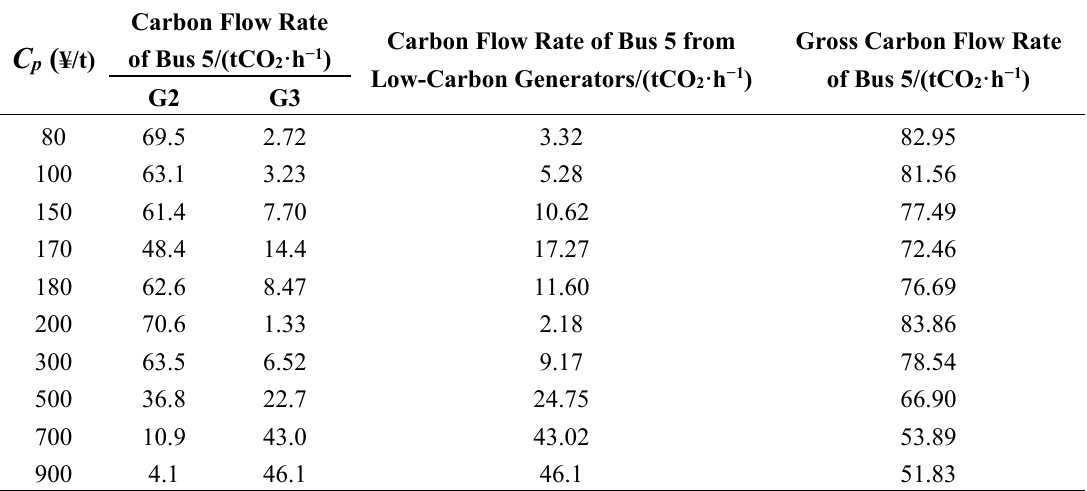
Table 4. Results under the condition of different carbon emission